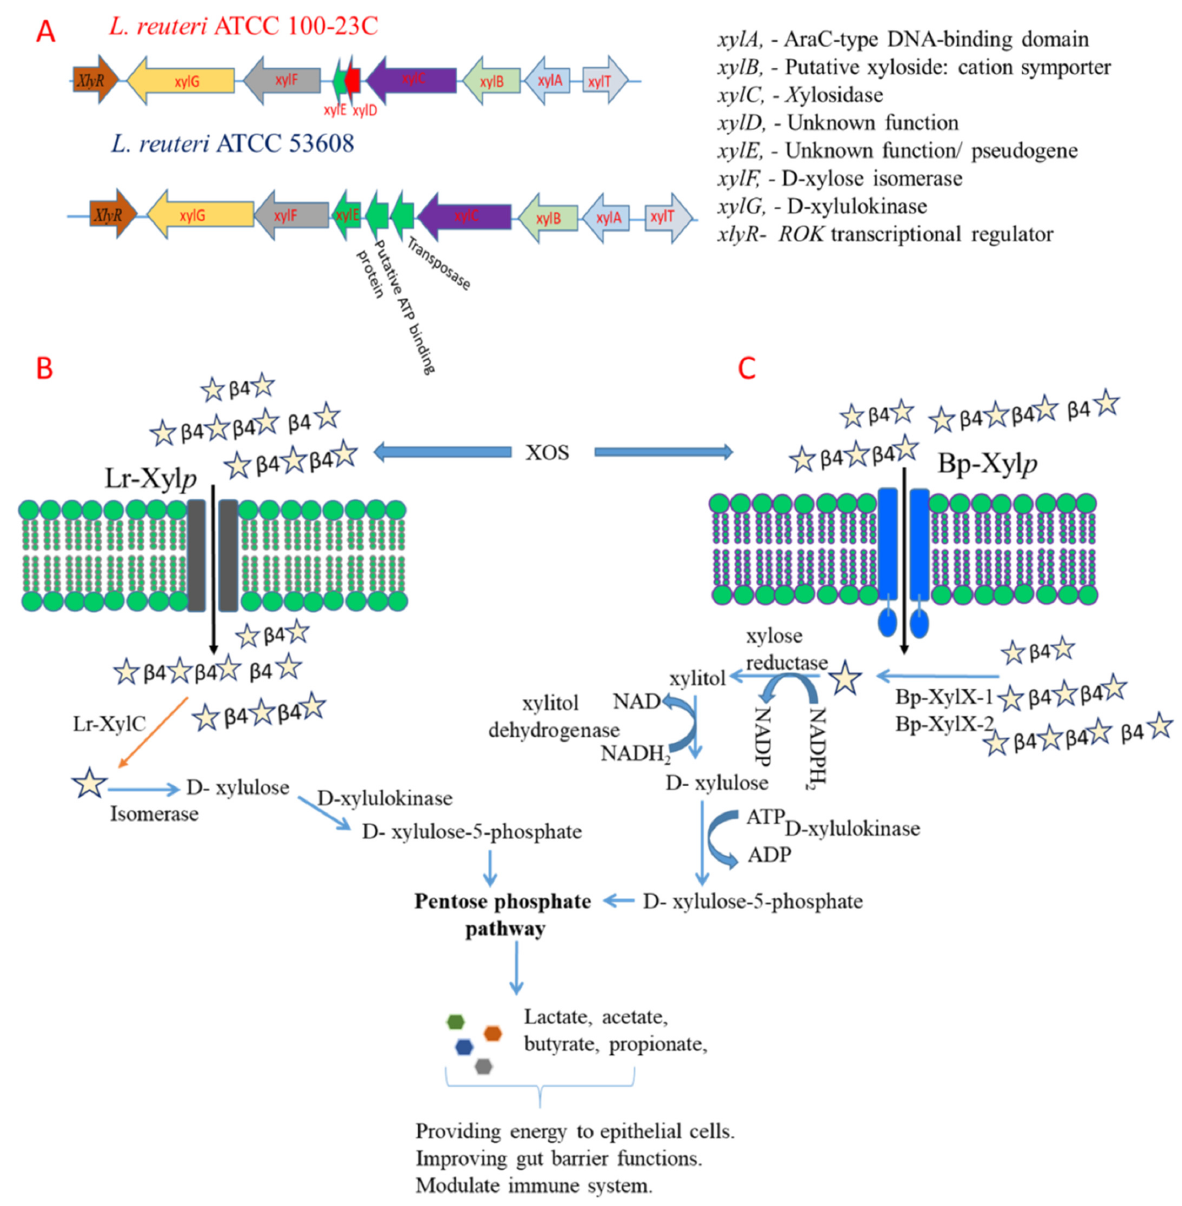
Figure 8. Identification of the XOS-utilising locus in L. reuteri and prediction of XOS metabolic pathways in L. reuteri and B. producta strains. Identification of the XOS-utilising locus in L. reuteri ATCC 53608 and ATCC 100-23C ( A ). Predicted metabolic pathway for XOS utilising in L. reuteri ATCC 53608 and ATCC 100-23C ( B ), and B. producta ATCC 27340 ( C ). During fermentation of XOS, these bacteria can produce SCFA, which can improve human health.